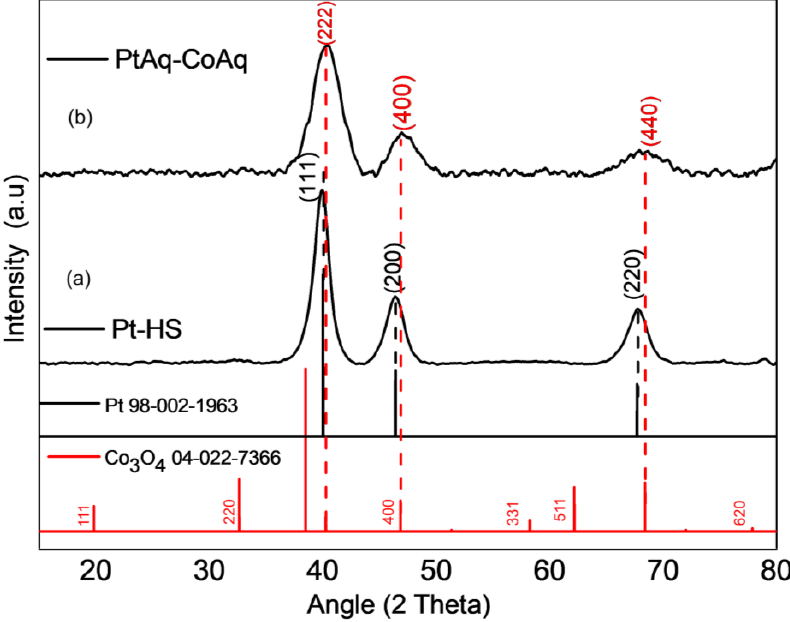
Figure 3. The XRD patterns obtain for Pt-HS ( a ) and PtAq-CoAq ( b ).